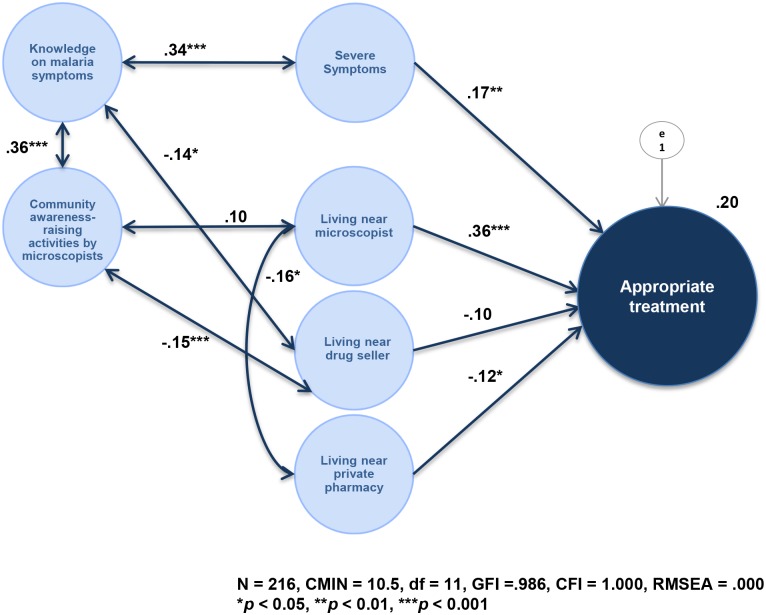
Determinants of appropriate treatment.N = 216, CMIN = 10.5, df = 11, CFI = 1.000, RMSEA = 0.000. * p < 0.05, ** p < 0.01, *** p < 0.001. Since the two participants who first sought treatment from a traditional healer (Tagalog: Albalaryo) made a very unusual choice, the authors analyzed them separately and did not include them in the SEM model.